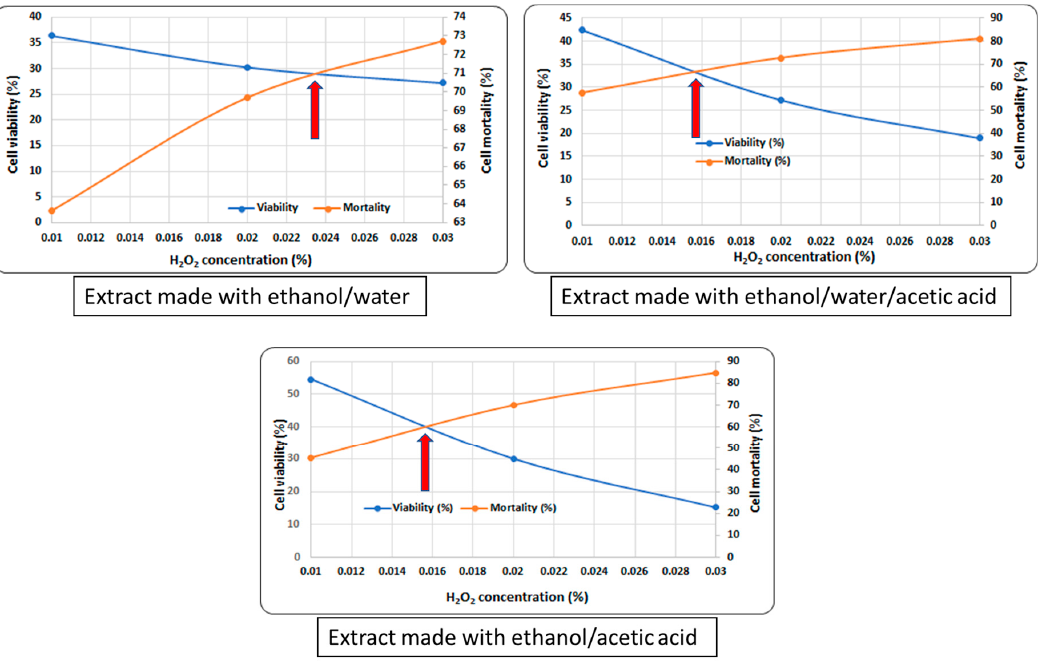
Figure 2. The cell viability as a parameter of the in vivo antioxidant activity in the presence of C. longa extracts.